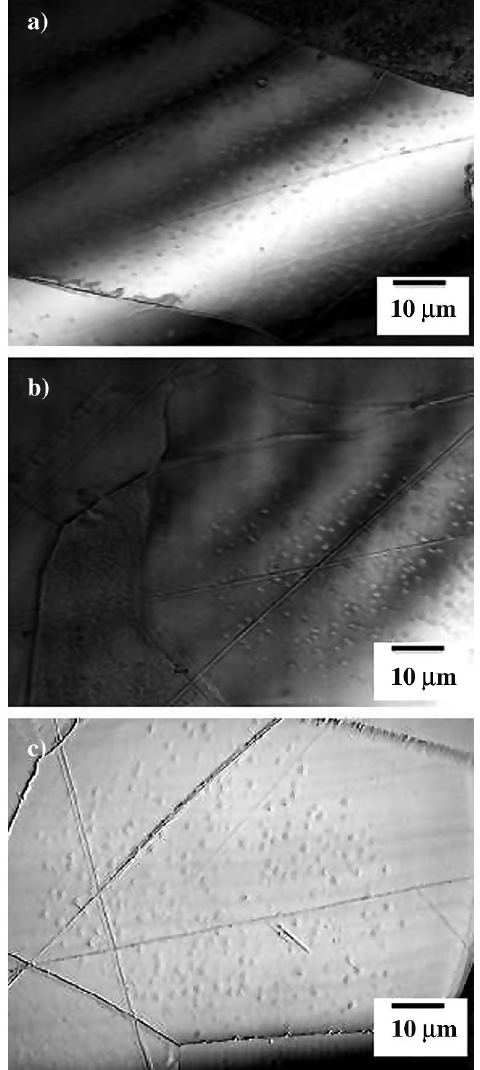
FIG. 6. Patterns obtained after keeping electropolished sample at 140 K for (a) 1; (b) 2; and (c) 4